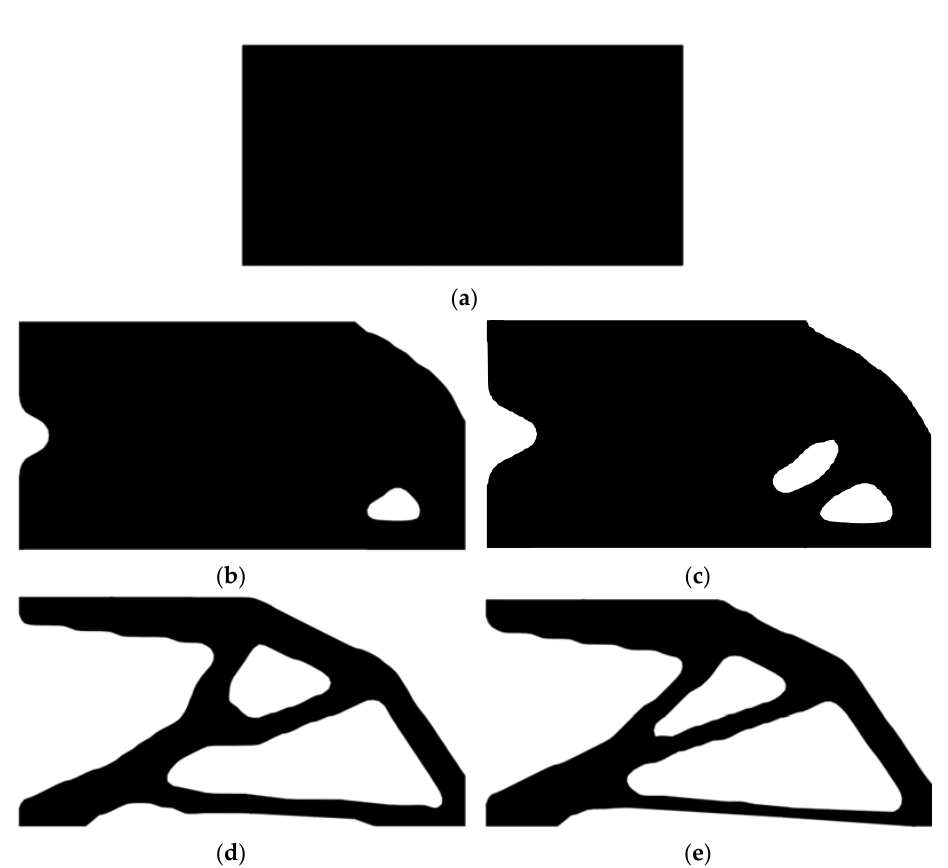
Figure 25. Optimal design problem of cantilever beam by CBT level set topology optimization, ( a ) initial shape; ( b ) iteration 20; ( c ) iteration 40; ( d ) iteration 60; ( e ) optimized shape.